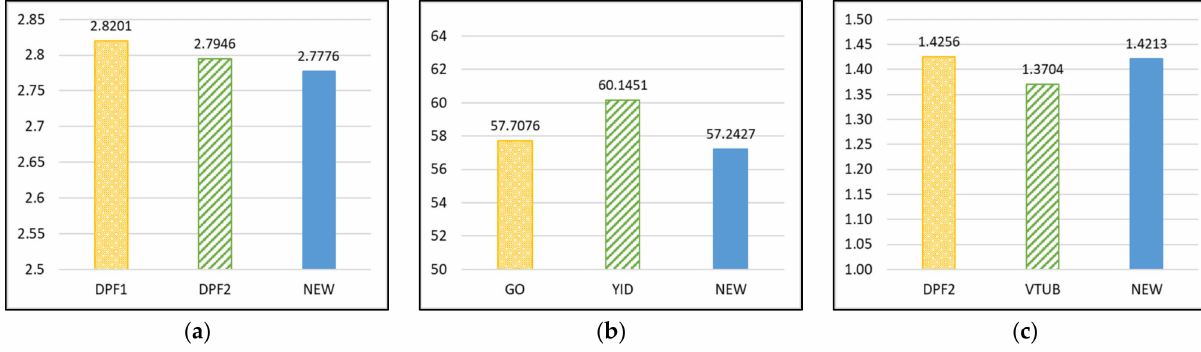
Figure 2. Three criteria values of top three models for dataset 2. ( a ) MSE; ( b ) AIC; ( c ) RMSPE. Figures 3 and 4 present the 95% confidence intervals of the datasets, the formula of which is given by